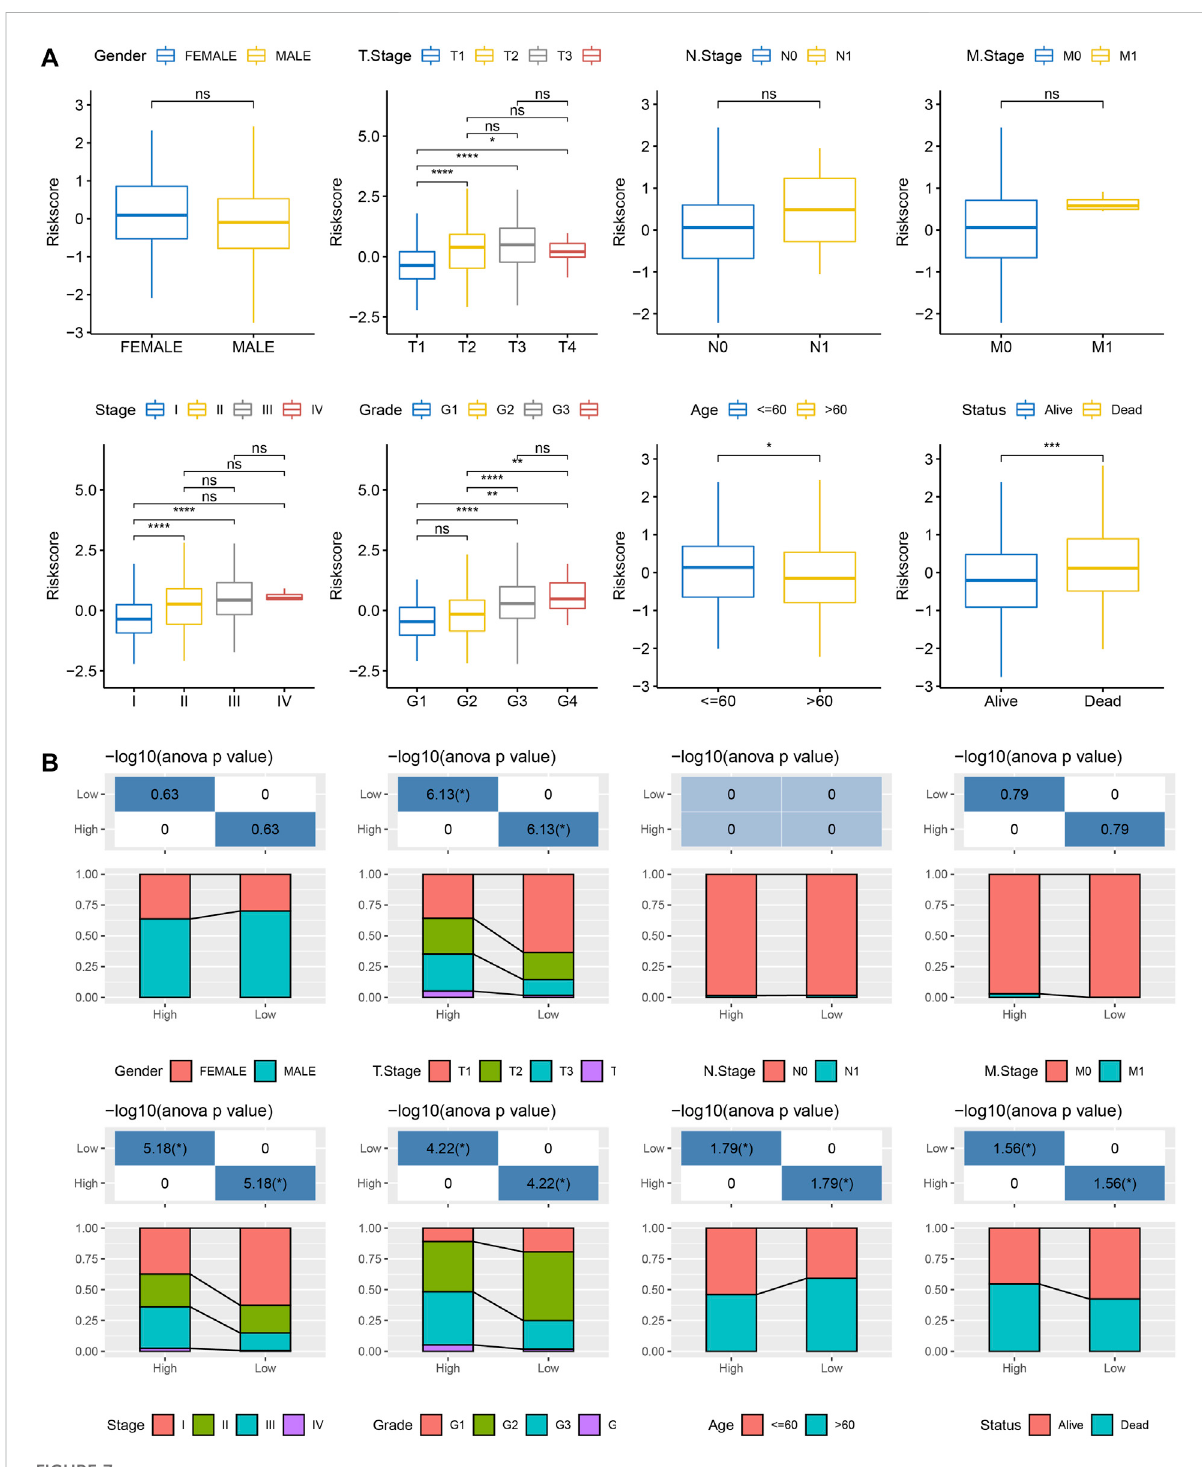
FIGURE 7 CorrelationbetweenRSandclinicopathologicalfeatures. (A)